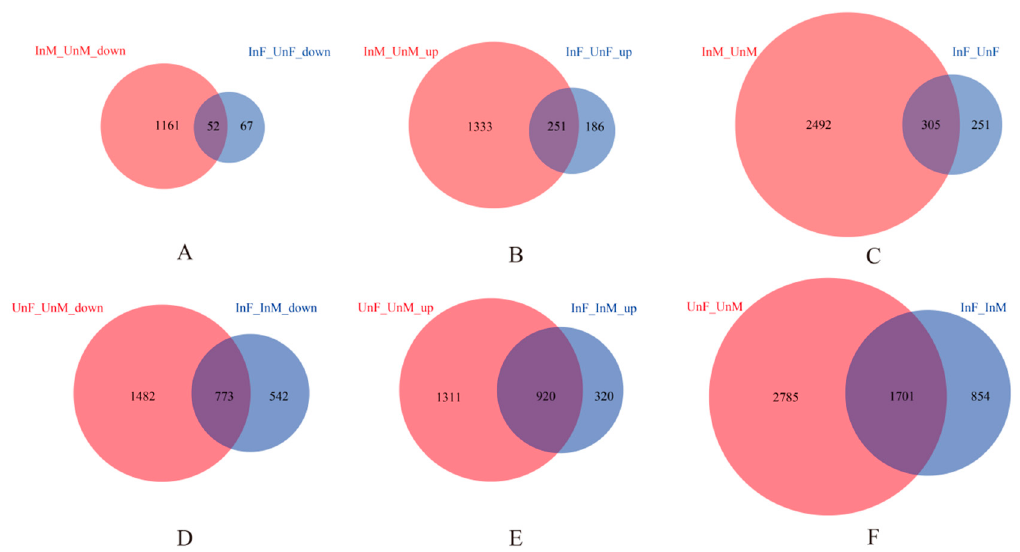
Figure 1. The differentially expressed genes (DEGs) analyses. We compared the “ Wolbachia -infection associated DEGs” and the “Gender associated DEGs”. (1) In the comparison of “ Wolbachia -infection associated DEGs” ( A – C ) between Cera + and Cera − samples in each gender, by setting the Cera − samples as the controls, we classified the DEGs into three groups: the downregulated, upregulated, or unclassified genes in Cera + samples. There are thus three groups of DEGs in males: downregulated in Cera + male (InM_UnM_down), upregulated in Cera + male (InM_UnM_up), and DEGs between Cera + and Cera − males (InM_UnM), and the same three groups of DEGs in females: downregulated in Cera + female (InF_UnF_down), upregulated in Cera + female (InF_UnF_up), and DEGs between Cera + and Cera − females (InF_UnF). For each of the three groups of DEGs, we then compared the overlapping pattern between both genders, and obtained shared DEGs in both genders and the gender-specific DEGs. For example, as Figure 1A shows, in the downregulated DEGs in Cera + samples, there are 1161 genes unique downregulated in males, 67 unique in females, and 52 shared in both genders. (2) In the comparison of “Gender associated DEGs” ( D – F ), between both genders’ samples in Cera + or Cera − lineage, there are also three groups of DEGs in each lineage: downregulated in female, upregulated in female, and DEGs between both genders. For each of the three groups of DEGs, the overlapping pattern between Cera + and Cera − lineages were compared, and the shared DEGs, lineage-specific DEGs were obtained.